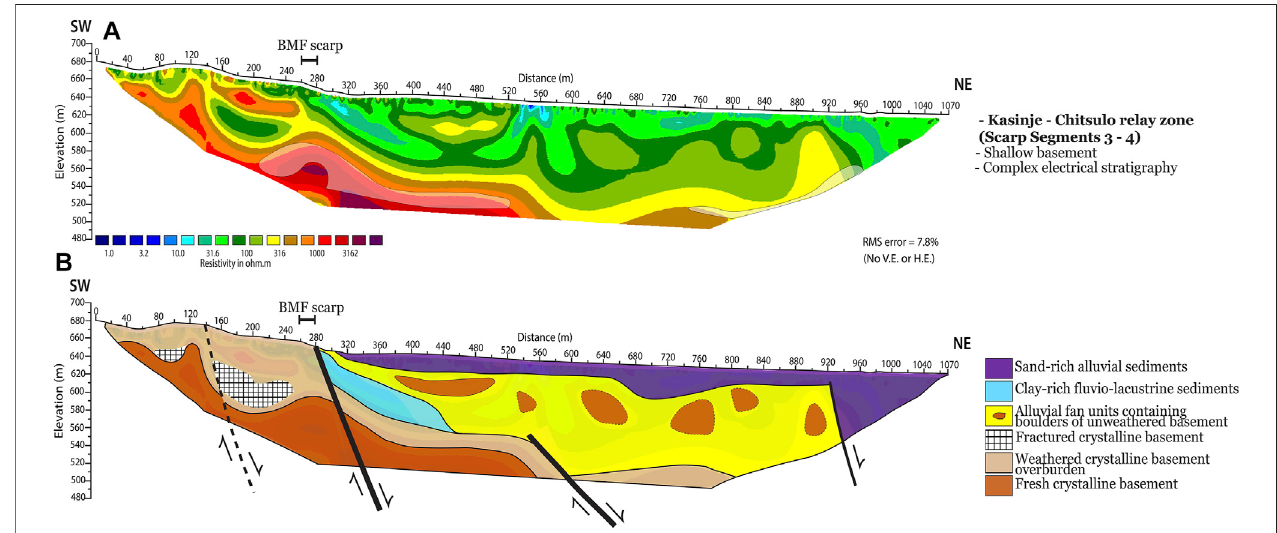
FIGURE 9 | (A) Inverse model of the ERT Pro fi le 3, acquired at the relay zone in-between Scarp Segments 3 and 4 (transition from Kasinje to Citsulo geometrical segments) in the central section of the BMF. The white transparent polygons are areas of low model sensitivity ( Supplementary Figure S2A ). (B) Geologic model and interpretation oftheresistivitymodel. The inversion model and interpretation re fl ects alowangle fault plane alongtheBMF becausethesurveypro fi le wasacquired at an oblique angle to the strike of the fault scarp due to land accessibility challenges encountered on the fi eld.